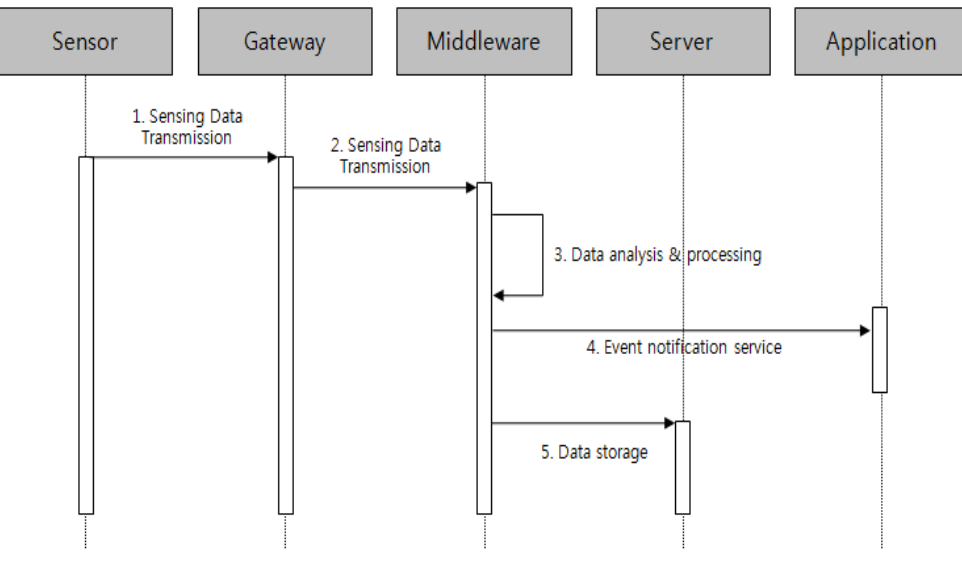
Figure 8. Sequence diagram of event